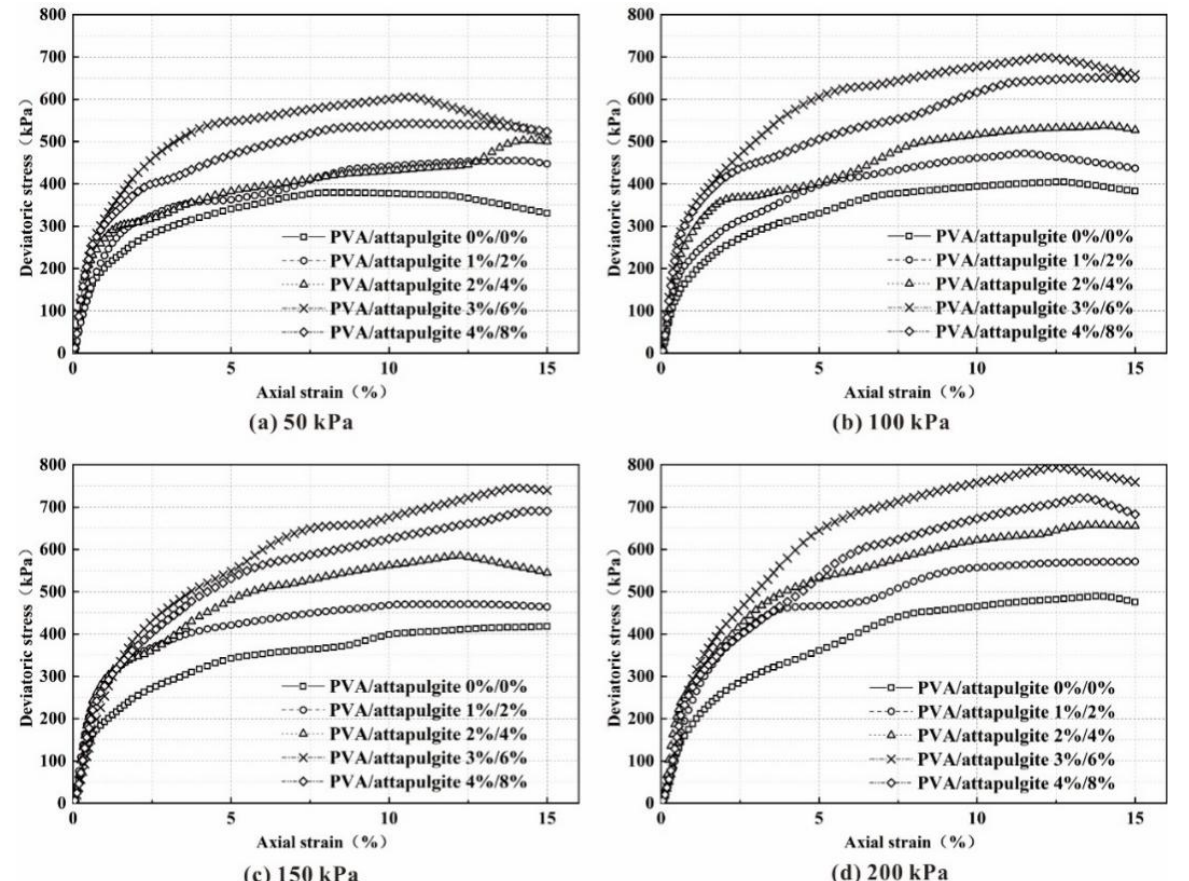
Figure 6. The deviatoric stress–strain curve of reinforced specimens under a confining pressure of: ( a ) 50 kPa; ( b ) 100 kPa; ( c ) 150 kPa; ( d ) 200 kPa.